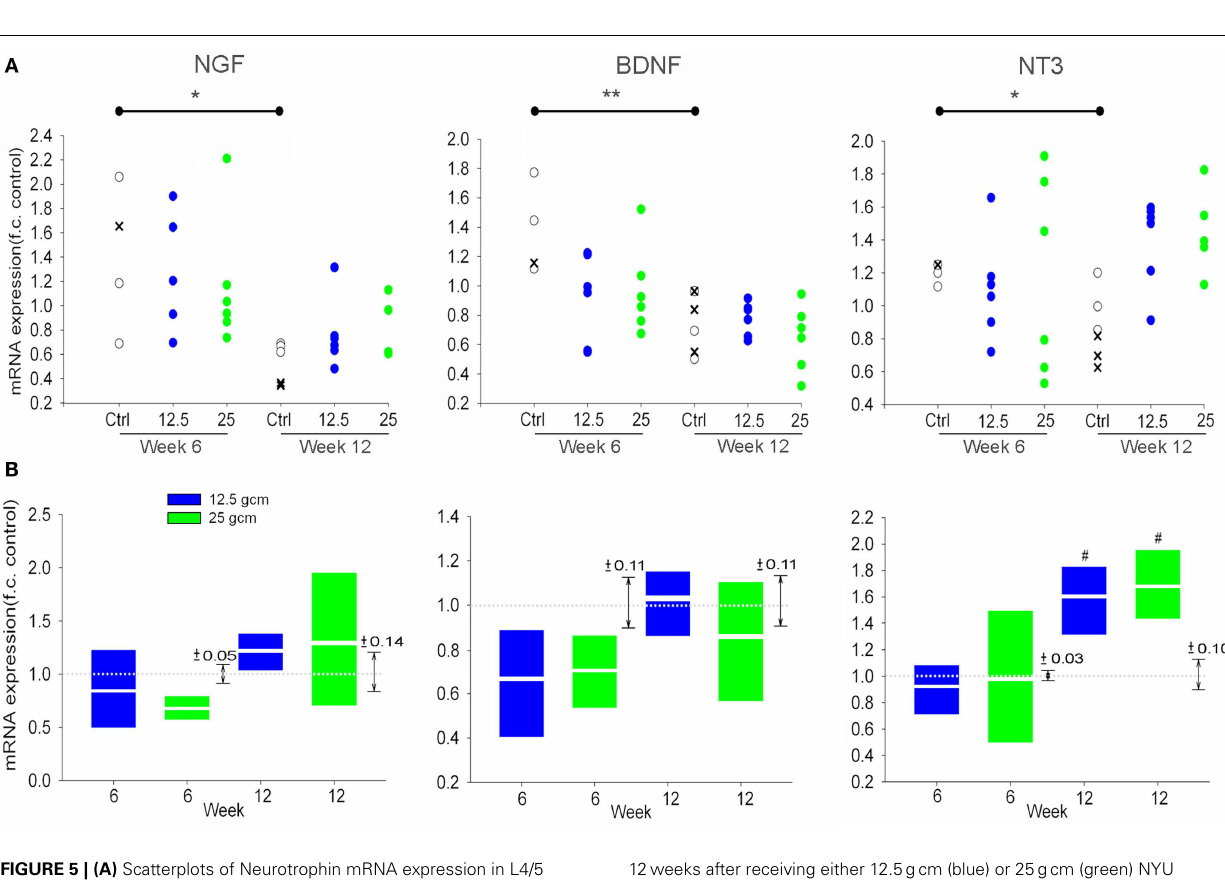
FIGURE 5 | (A) Scatterplots of Neurotrophin mRNA expression in L4/5 SC at 6 and 12weeks after receiving either 12.5gcm (blue) or 25gcm (green) NYU contusion injury to spinal cord at vertebral levelT9, relative to the unified control group as was done for the other data . x ’s represent mRNA expression of age-matched naive animals. Open circles represent expression of age-matched laminectomy control animals. * p < 0.05, ** p < 0.01 (B) mRNA expression of Neurotrophins in L4/5 SC at 6 and